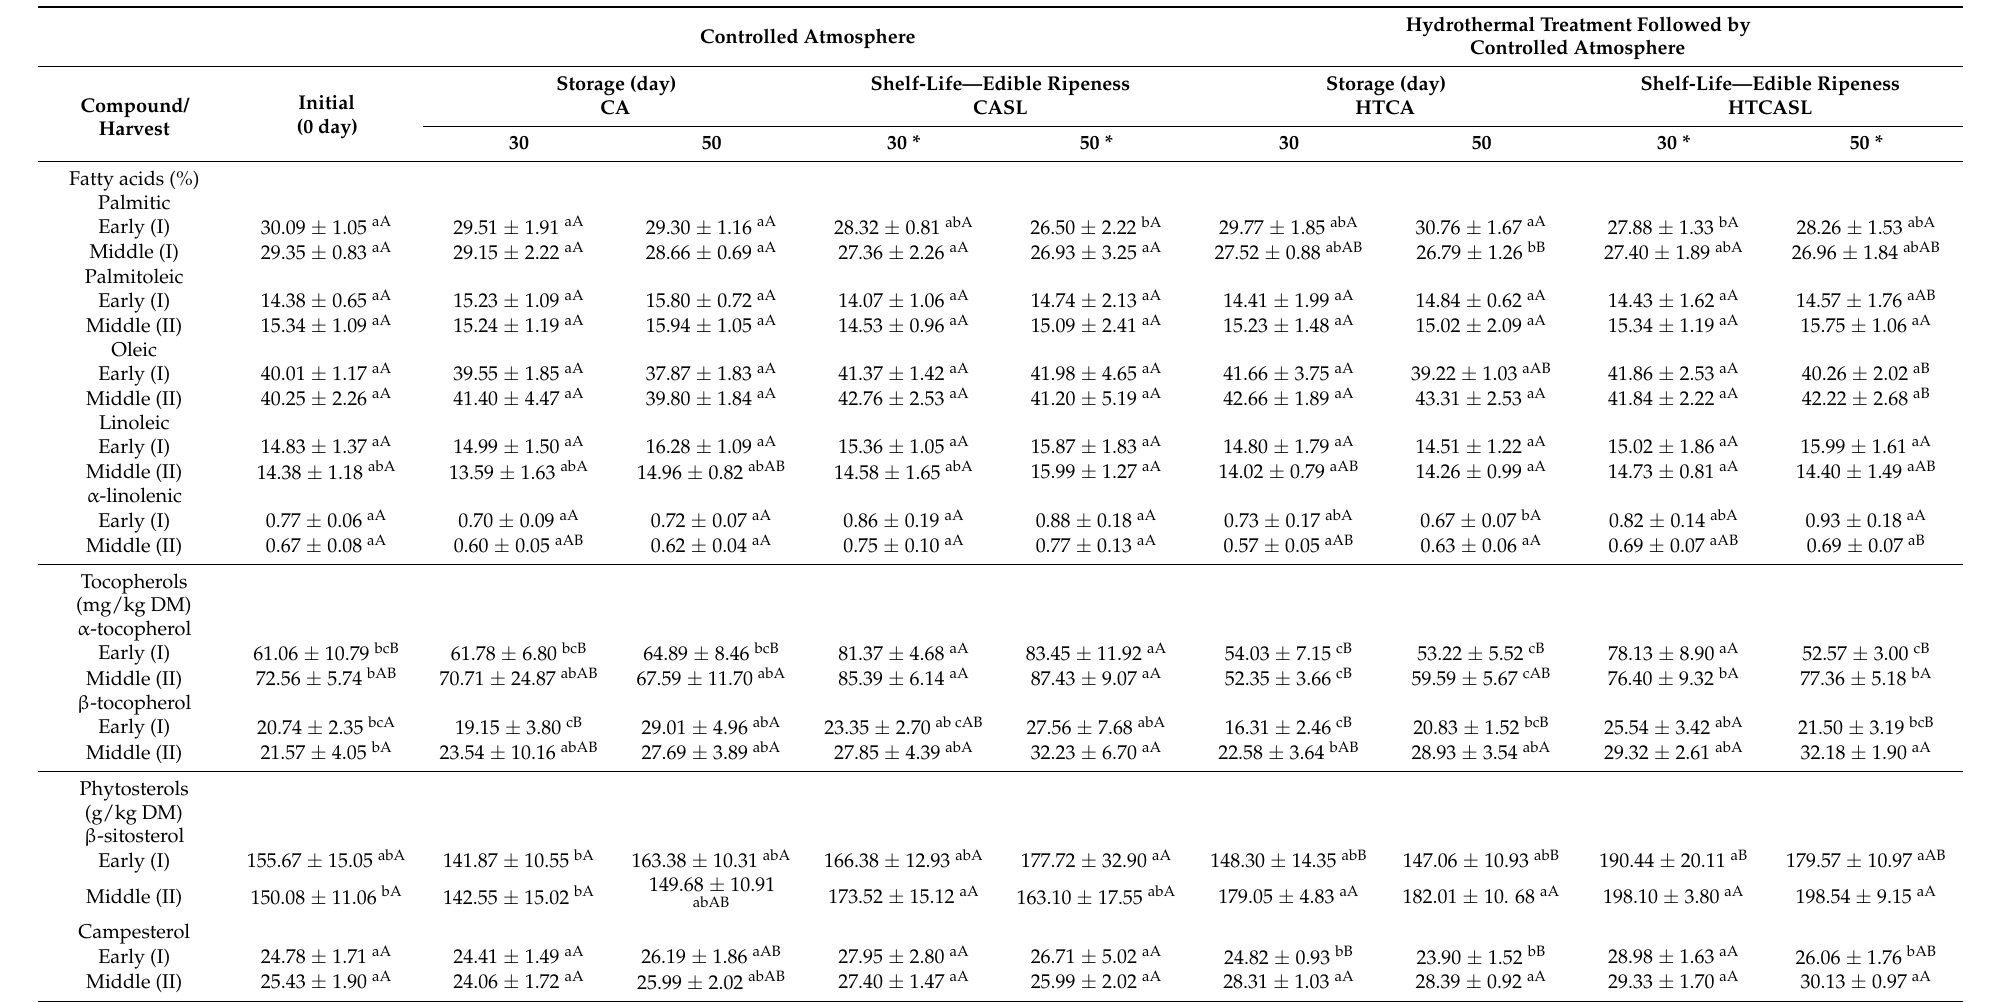
Table 2. Content of fatty acids, tocopherols, phytosterols, abscisic acid, and hydrophilic and lipophilic antioxidant activity in Hass avocado from two harvests (early and middle) at harvest (initial), after controlled atmosphere storage, and with previous hydrothermal pretreatment followed by controlled atmosphere storage, and at their corresponding edible